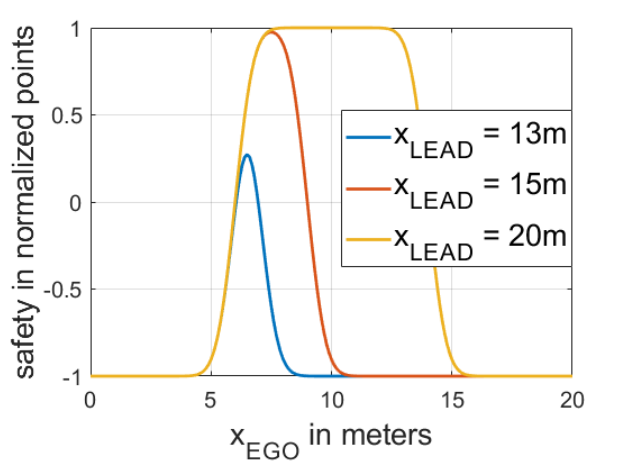
Figure 5. Dependencies between the EGO’s safety payoff function and the position of EGO ( x EGO ). Note that x LEAD is the longitudinal position of LEAD, which determines the distance between FV and